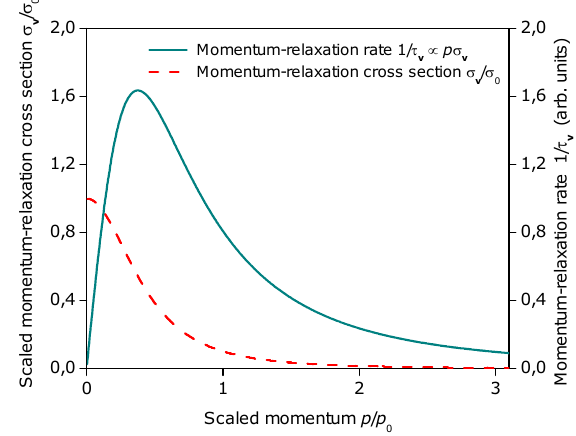
Fig. 5 . The rate of momentum relaxation (1/ τ function of the scaled momentum together with the momentum-relaxation scattering cross section ( σ